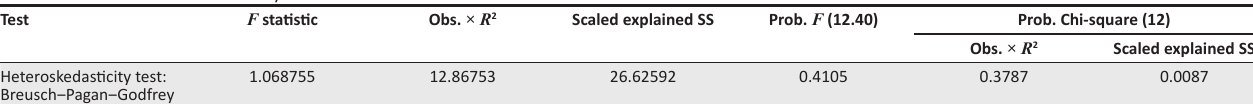
TABLE 11: Test for heteroschedaticity for Buffalo metro.